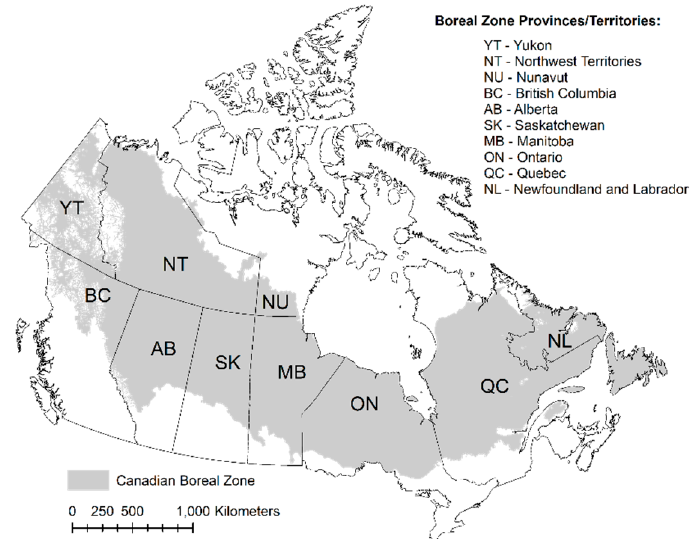
Figure 1. Extent of the North American boreal zone [1] across Canada and in relation to provincial and territorial jurisdictional boundaries.